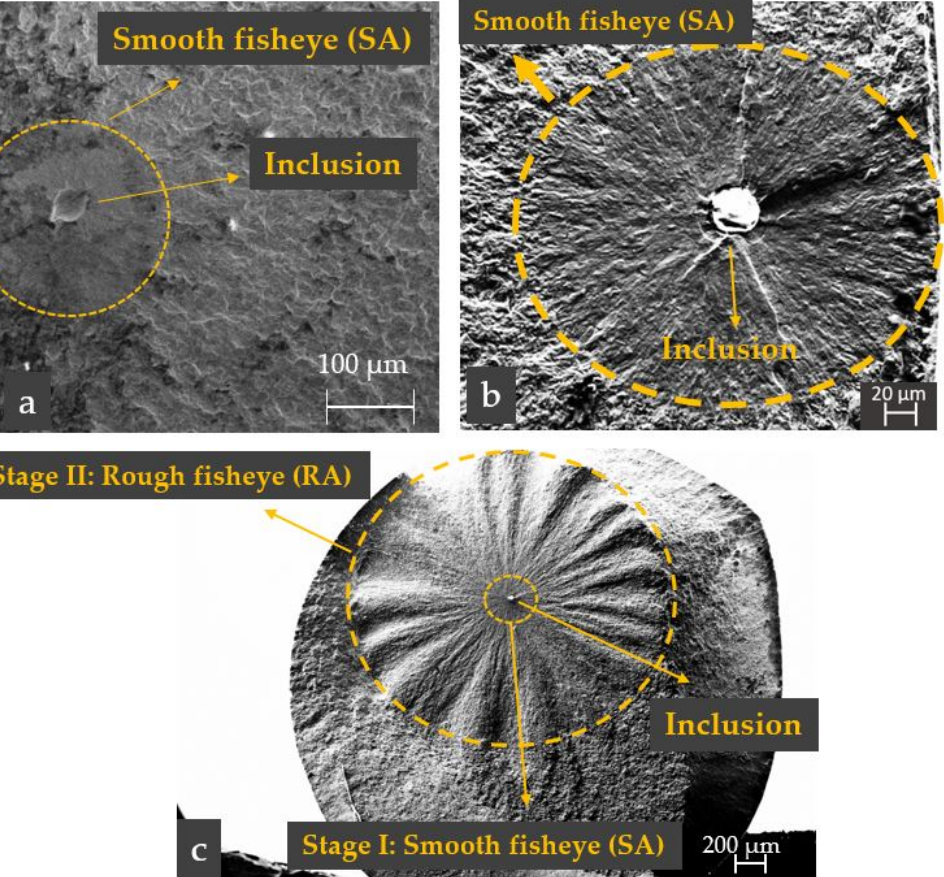
Figure 9. Fisheye formation analysis of fracture surfaces at a stress amplitude of 775 MPa. ( a ) TMT specimen, inclusion is surrounded by a smooth fisheye (fisheye formation in a single stage, N f = 4,932,070 cycles, inclusion depth = 125 µ m); ( b ) HT specimen, inclusion is surrounded by a smooth fisheye (fisheye formation in a single stage, N f = 6,722,705 cycles, inclusion depth = 180.8 µ m); ( c ) TMT specimen, inclusion is surrounded by a small smooth fisheye around the inclusion and a bigger rough fisheye around the smooth one (fisheye formation in two stages, N f = 9,706,545 cycles, inclusion depth = 1.3